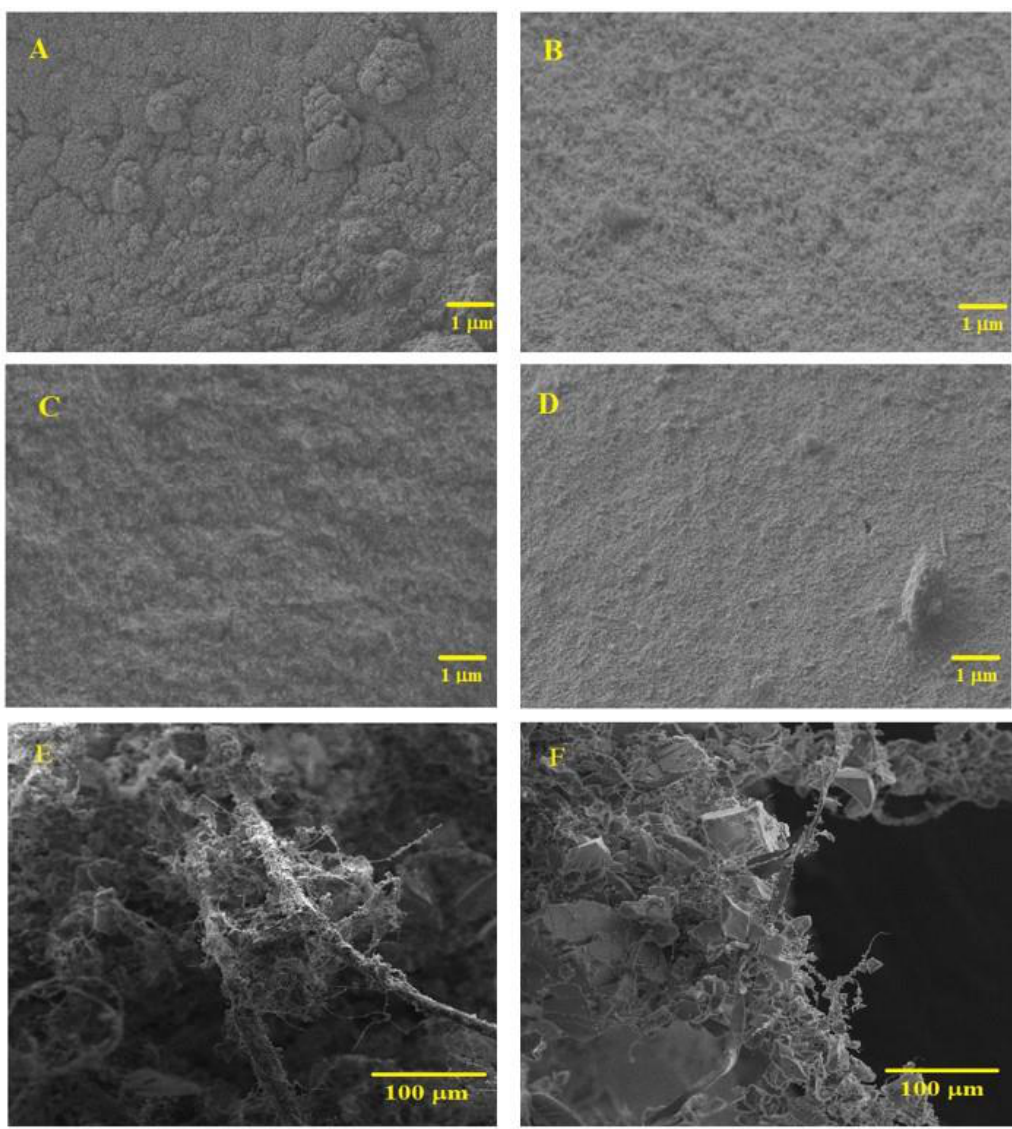
Figure 4. SEM images of aerogel composites obtained from TEOS ( S = 10) ( A ) before and ( B ) after silylation. Same magnification images for silylated samples obtained from ( C ) TEOS ( S = 6) and ( D ) TEOS 0.7 /VTMS 0.3 ( S = 10). Fiber dispersion in the TEOS-derived matrix with ( E ) S = 6 and ( F ) S = 14.